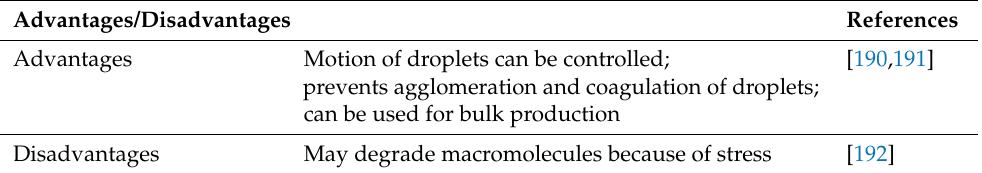
Table 12. Some of the significant advantages and disadvantages of electrospray techniques are mentioned in this